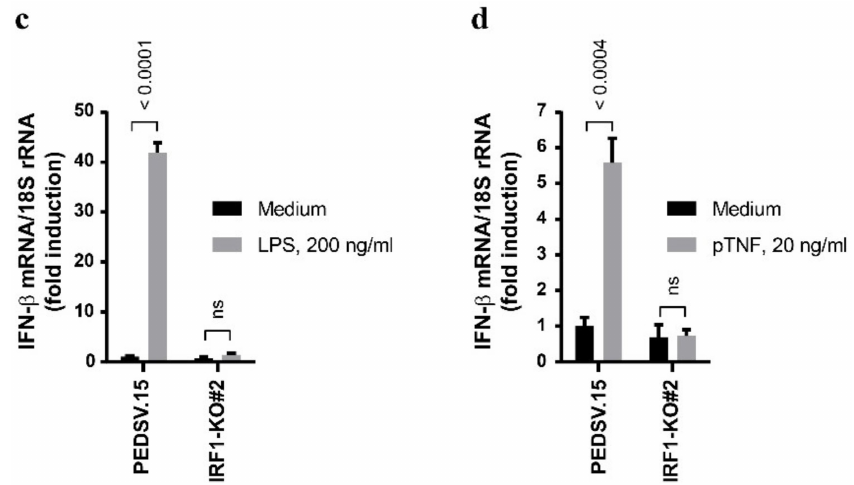
Figure 4. The anti-CSFV activities of LPS and TNF are IRF1-dependent. ( a ) PEDSV.15 cells expressing nonfunctional IRF1 were generated with CRISPR/Cas9-based genome editing. ( b ) Two independent knockout clones (#2 and #12) and the Cas9-exposed negative control (IRF1-WT#1) with intact IRF1 were stimulated with pTNF, LPS, IFN- β or the medium for seven hours followed by infection with CSFV-luc at a MOI of 0.1 TCID 50 /cell for 22 h before the cell lysates were processed for firefly luciferase measurement. ( c , d ) The effect of two hours of stimulations with LPS ( c ) or pTNF ( d ) on the expression of IFN- β mRNA normalized to 18S ribosomal RNA was assessed in the PEDSV.15 and IRF1-KO#2 cells. The data in ( b ) represent the means and the standard deviations of six independent experimental replicas and significant differences compared with the medium ( p < 0.05) were calcu- lated with one-way ANOVA and post hoc tests ( p -value indicated; ns, nonsignificant). The data in ( c , d ) represent the means and the standard deviations of three independent experimental